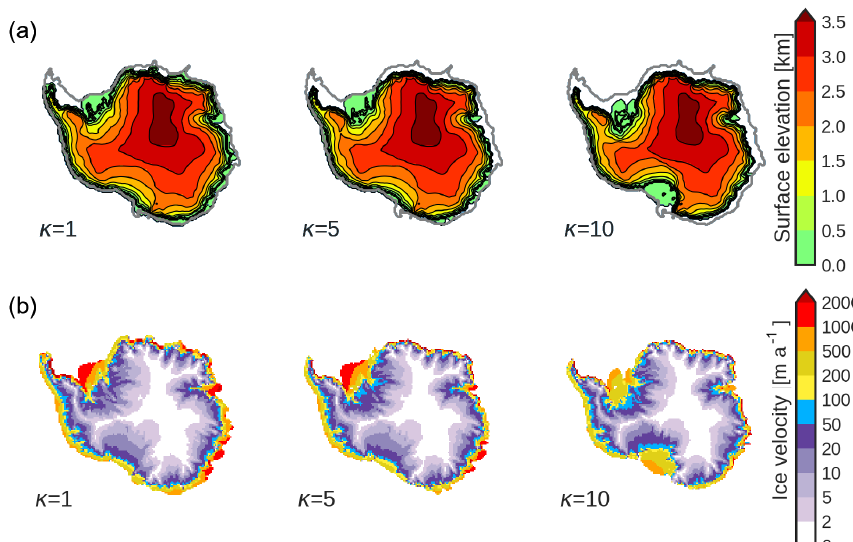
Figure 5. Snapshots of the AIS simulations at the end of a warm phase (AIM) event (57ka) for three different oceanic sensitivities ( κ = 1, 5, and 10ma − 1 K − 1 ). (a) Surface elevation (in km). The thick black line indicates the grounding line position, and the thick grey line is the continental shelf break. (b) Ice velocities (in ma − 1 ).